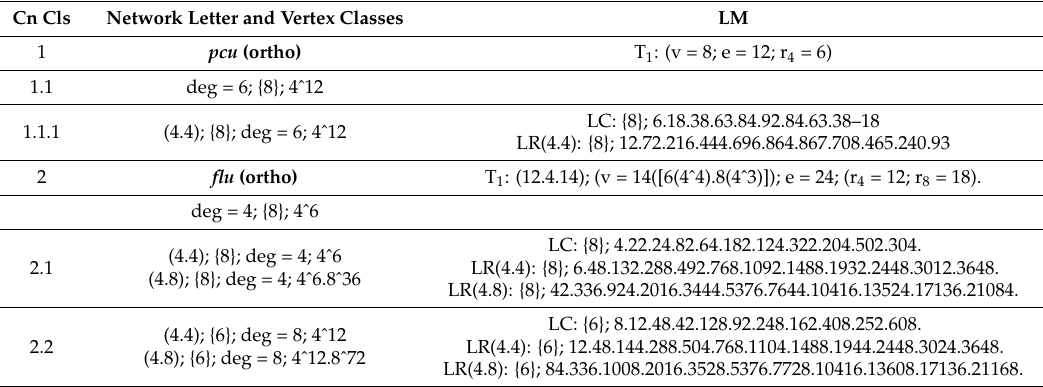
Table A3. Corner coalesced pcu , flu and deffect (mtp) pcu networks: unit/tile; vertex connectivity classes; ring domain; population; degree; point symbol; LM sequence: connectivity (LC) and atom surrounding rings